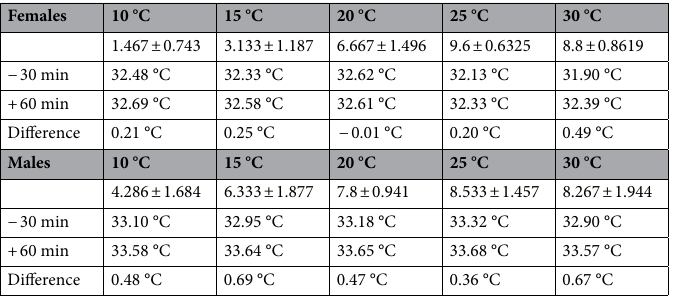
Table 5. Absolute satisfaction values with cooling temperatures and surface skin temperature of males and